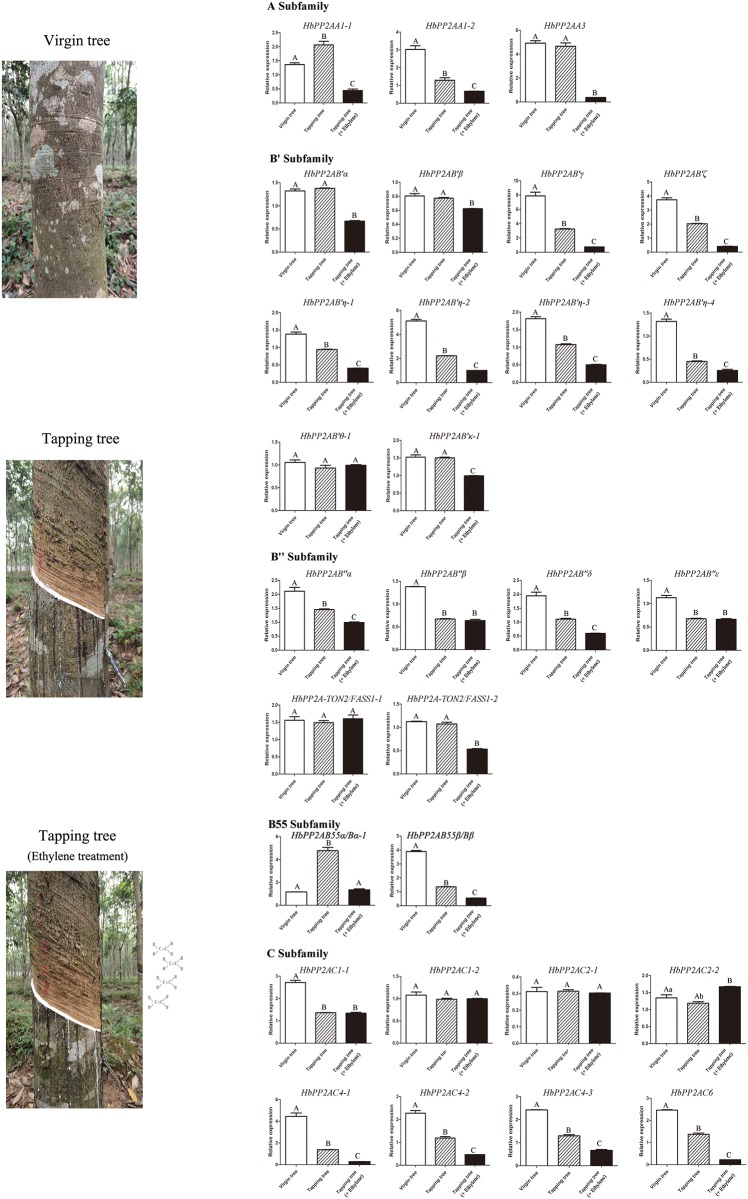
Expression profiles of HbPP2As in latex upon ethrel treatment and tapping.Error bars for qRT-PCR showed the standard deviation of three replicates. Different letters indicate statistically significant difference in the relative expression of each gene among different treatments. The capital letter represents p < 0.01 while lowercase represents p < 0.05.